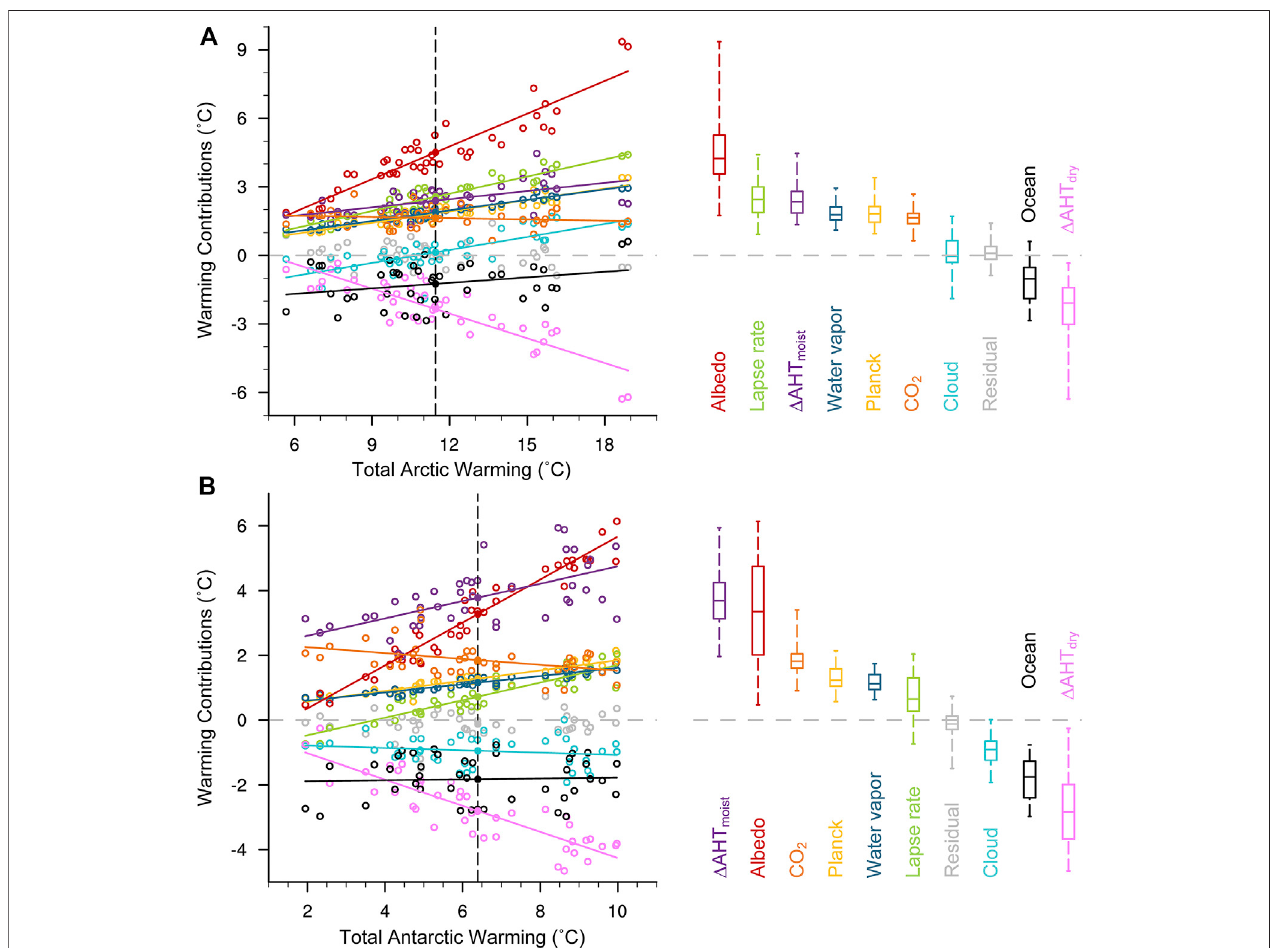
FIGURE 6 | Intermodel spread of warming contributions versus total warming ( ˚ C) in individual models for (A) the Arctic and (B) the Antarctic in CMIP6. Solid lines show linear regressions of feedback contributions against total warming at each pole. Filled circles on the black dashed line show the CMIP6 multimodel mean. In the right-hand panel, boxes indicate the median and 25th and 75th percentiles, and whiskers show the full intermodel spread of polar warming contributions.